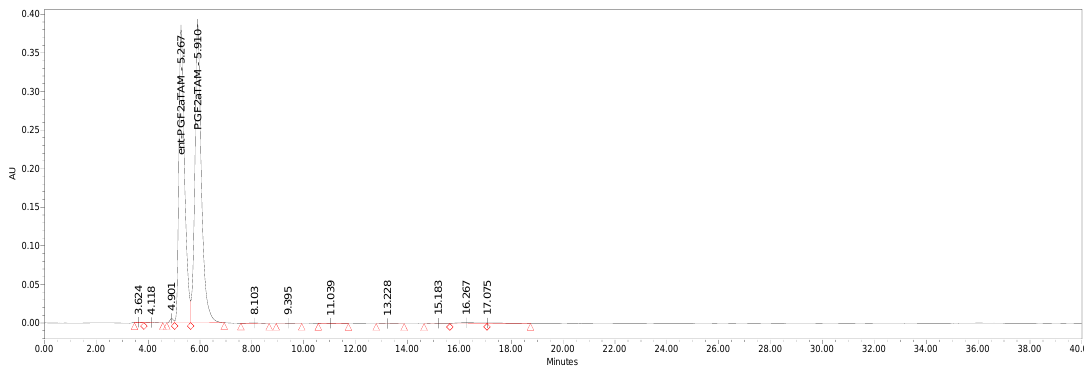
Figure 1. Effect of the variable parameters on the resolution of PGE 2 enantiomers. By varying the indicated parameters, we performed the chiral separation of all four enantiomeric pairs with excellent resolution, R ≥ 1.5. The best resolutions are shown in Figures 2–5.